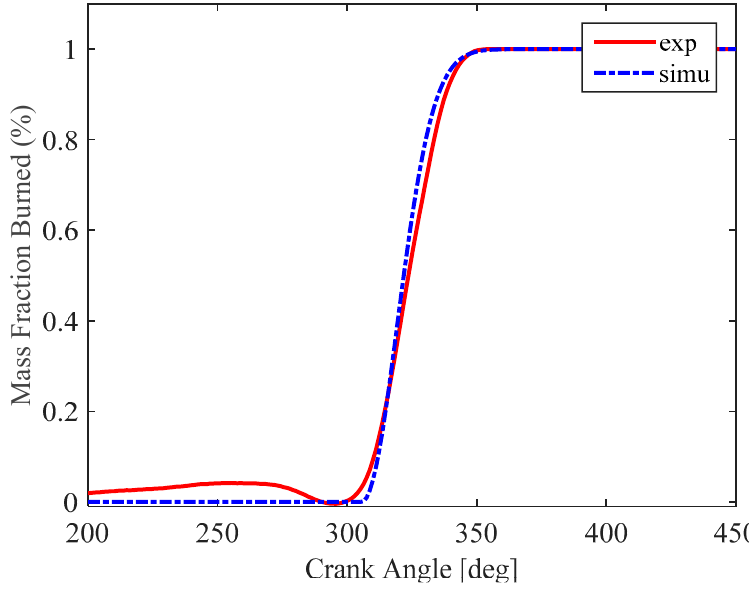
Figure 9. Mass fraction burned vs. crank angle for the experiments (solid red line) and simulations (dash blue line).